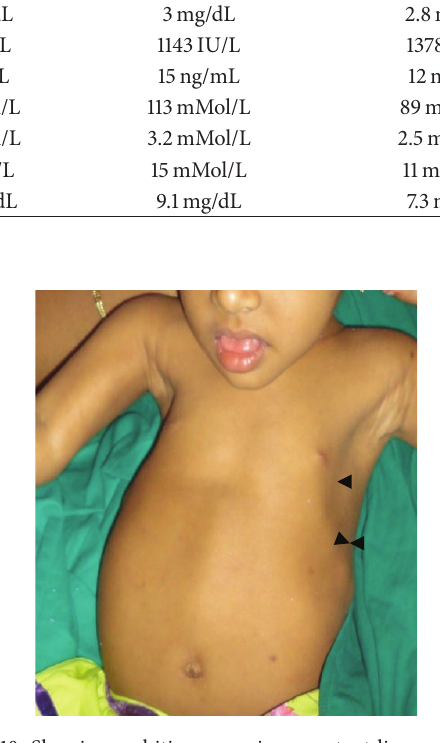
Figure 10: Showing rachitic rosary, incompetent lips, and macro- glossia.